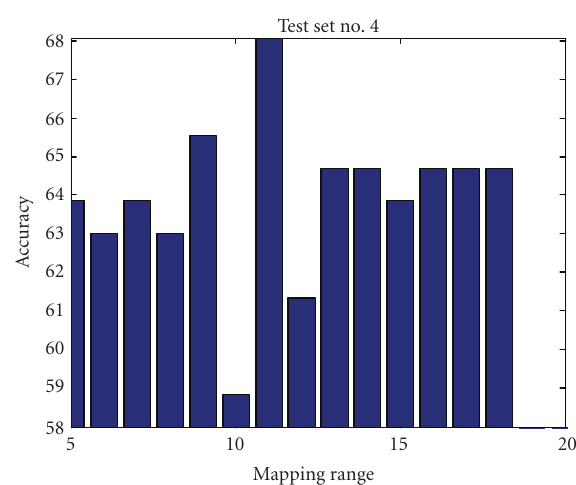
Figure 10: Mapping range impact on algorithm accuracy for test set no. 2.